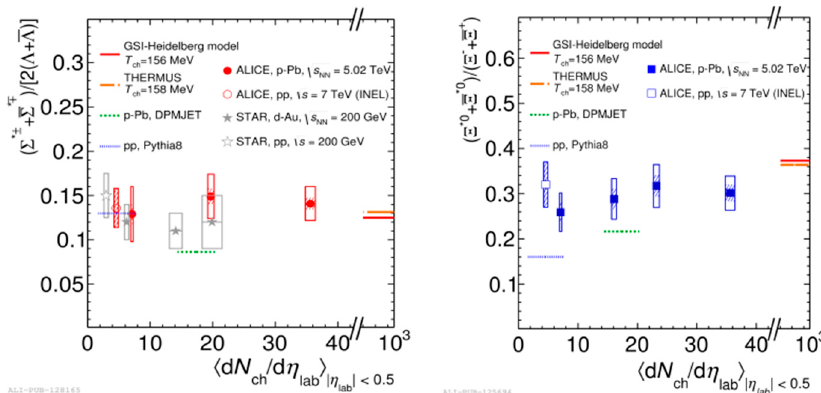
Figure 2. Ratio of Σ (1385) ± to Λ ( left ), Ξ (1530) 0 to Ξ − ( right ) measured in pp, d-Au and p-Pb collisions as a function of the mean charged-particle multiplicity density. Statistical (bars) and systematic uncertainties (boxes) are shown. The shaded boxes are the multiplicity uncorrelated systematic uncertainties. Model predictions are also presented as lines at the appropriate abscissa. Figure taken from [2].